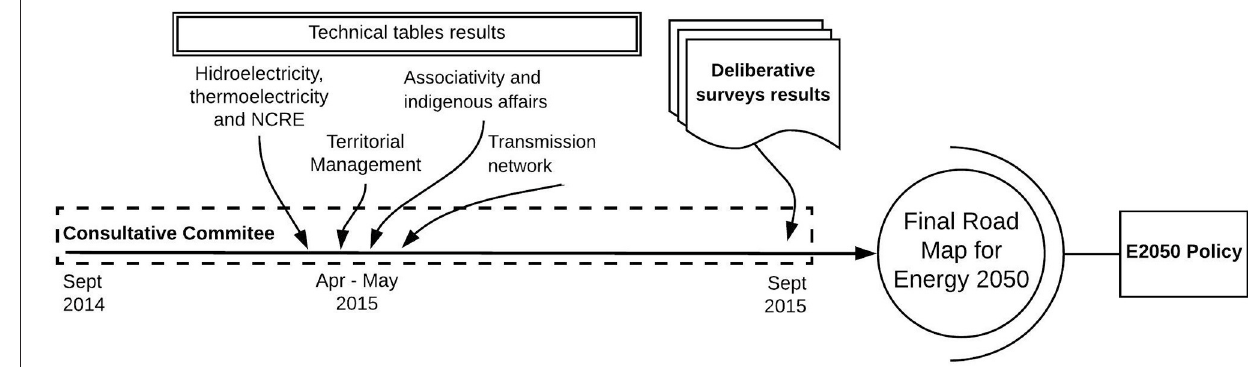
FIGURE 4 | Consultative Committee timeline.